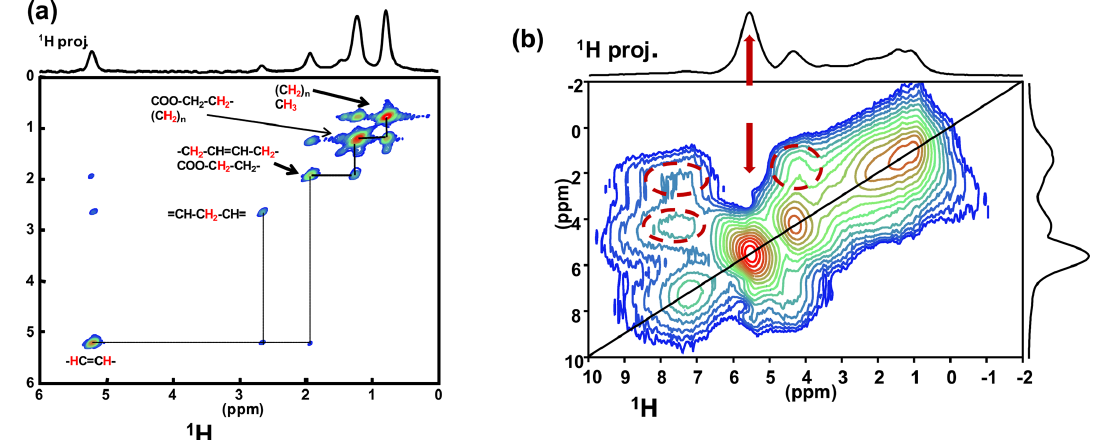
Figure 5. (a) 1 H − 1 H DQF COSY MAS NMR spectrum for KS3 at ν rot = 30kHz recorded at 16.4T. Here, no temperature control was implemented, leading to a ∼ 40 ◦ C increase in the local temperature and, therefore, of local dynamics. All peaks are assigned to contributions from unsaturated mobile fatty acids (with unsaturations). (b) 1 H − 1 H DQ BABA MAS NMR spectrum for KS3 at ν rot = 79kHz recorded at 16.4T (no temperature control; SQ–SQ, single quantum–single quantum, representation). The recoupling period is two rotor periods. Off-diagonal correlations (immobile organic moieties) are highlighted by dashed red ovals. The red arrows indicate the COM contribution.